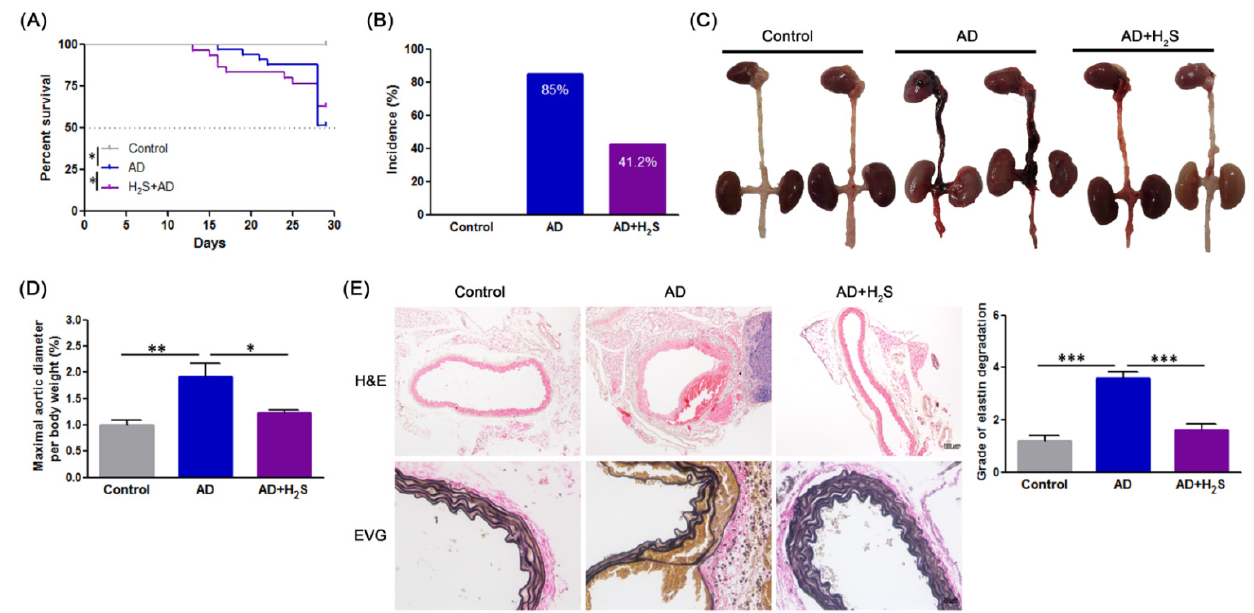
Figure 1. H 2 S ameliorates the etiopathology of BAPN/Ang-II-induced AD in mice. ( A ) Survival curves in indicated groups. ( B ) Incidence of AD. ( C ) Representative morphologies of aortas. ( D ) Maximal aortic diameter (normalized to body weight). ( E ) Representative HE and EVG staining in aorta, and quantification of elastin degradation in aortic wall ( n = 5 per group). The data are expressed as mean ± SD. Statistical significance: * p < 0.05, ** p < 0.01, *** p < 0.001.